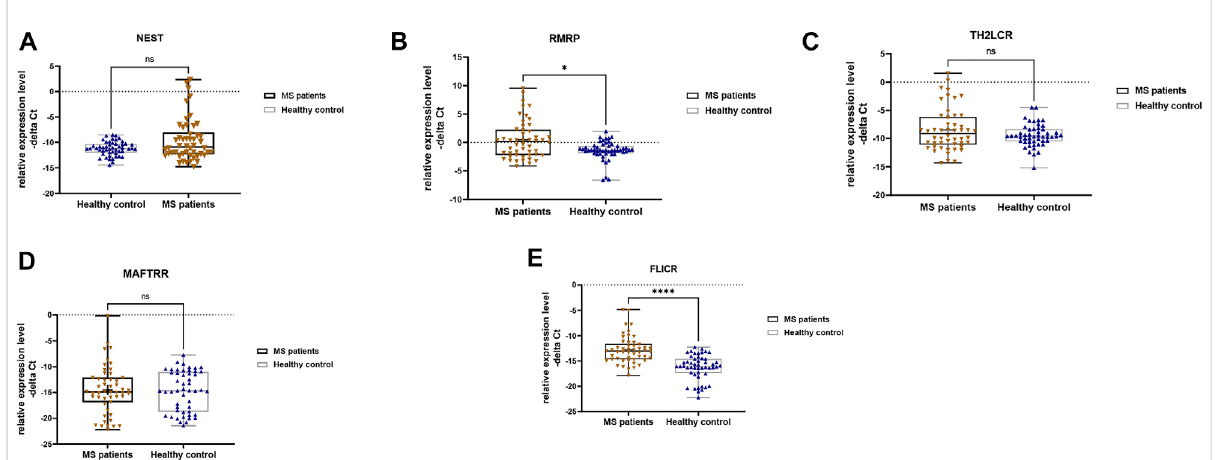
FIGURE 1 Relative expression levels of fi ve lncRNAs in total multiple sclerosis (MS) patients and controls as measured by – delta Ct values (A – E) . Mann- Whitney U test was applied to fi nd differentially expressed genes between cases and controls ( pp p value < 0.01 and pppp p value < 0.0001).